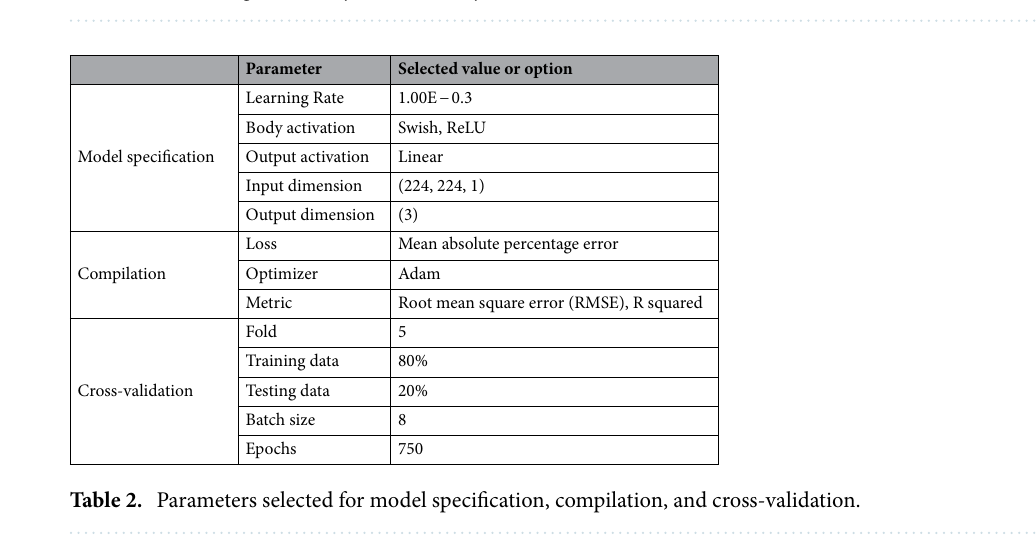
Figure 2. The flowchart of the developed model for chemistry and processing history prediction from microstructure images ( FC fully-connected layer).